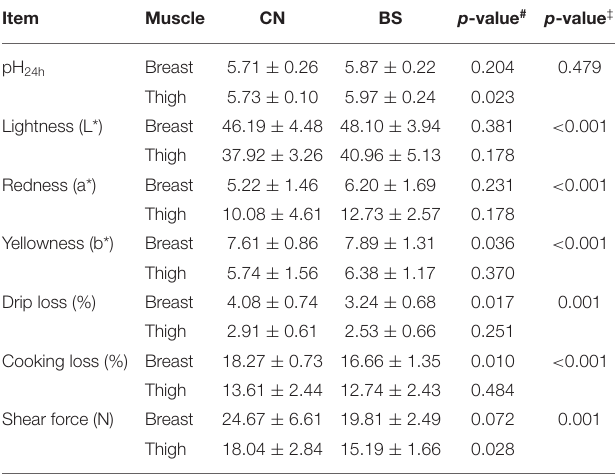
TABLE 3 | Effects of Bacillus subtilis supplementation on meat quality of broiler chickens.